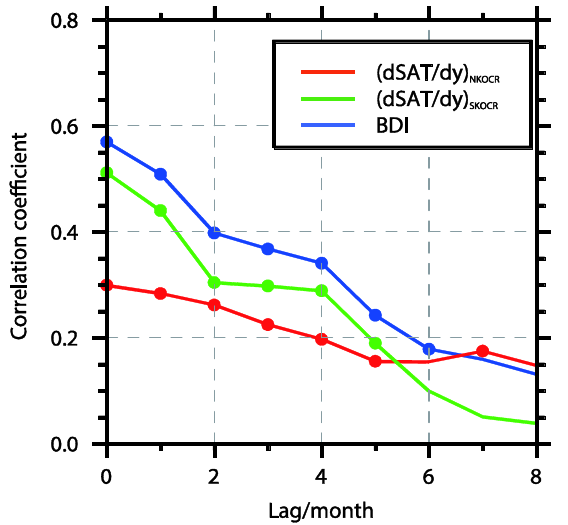
Figure 8. Correlation coefficients of the EAI with the (dSAT/dy) NKOCR (red line), (dSAT/dy) SKOCR (green line), and BDI (blue line) after a lag of 0‒8 months. Note that the sign of (dSAT/dy) SKOCR is reversed here for convenience of comparison. Dots indicate the correlations significant at the 95% confidence level.